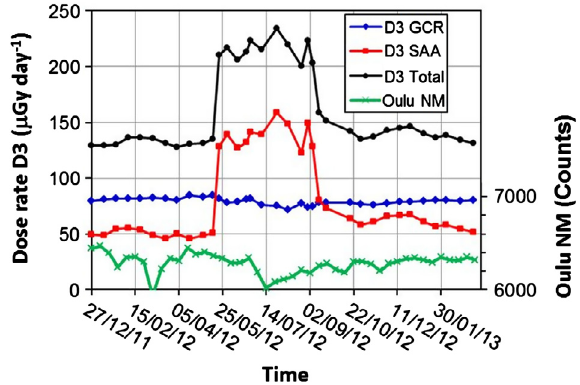
Fig. 5. Averaged dose rate distributions in D3 from 27 December 2011 to 09 March 2013. D3 total is in black, D3 in SAA is in red, and D3 from GCR is in blue. The Oulu neutron monitor count rate data is in